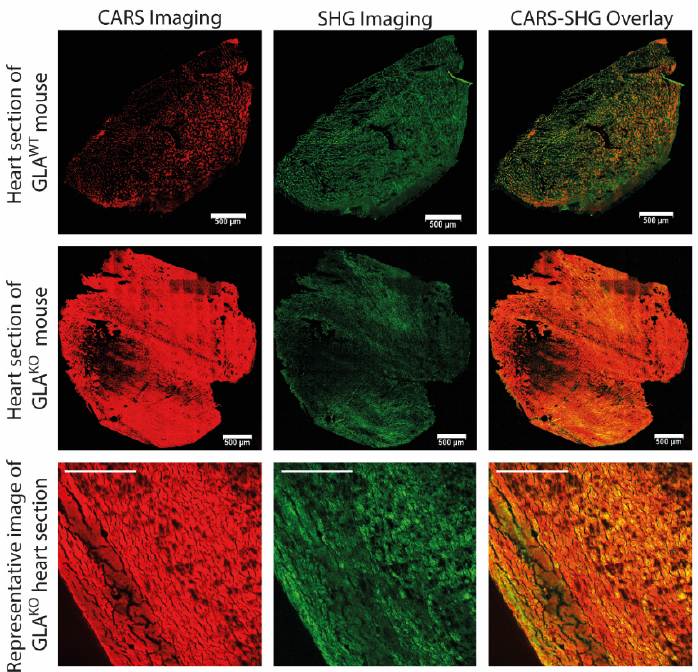
Figure 2 . Nonlinear spectroscopy for the characterization of FD manifestation in heart sections of GLA KO and GLA WT mice, including coherent anti-Stokes Raman scattering (CARS) and second harmonic generation (SHG) imaging and their overlays. The CARS pump laser was tuned to 816.5 nm. CARS signal is depicted in red (left column), the SHG signal is depicted in green (middle column), and the overlay image represents the merged picture of the CARS and SHG signals (right column). The scale bars represent 500 µm for the overview images of the cardiac tissue section scans of both genotypes (upper and middle row) and 100 µm for the lower row that shows a representative magnification of a GLA KO heart section. The overview pictures were stitched and merged automatically by the LasX software.